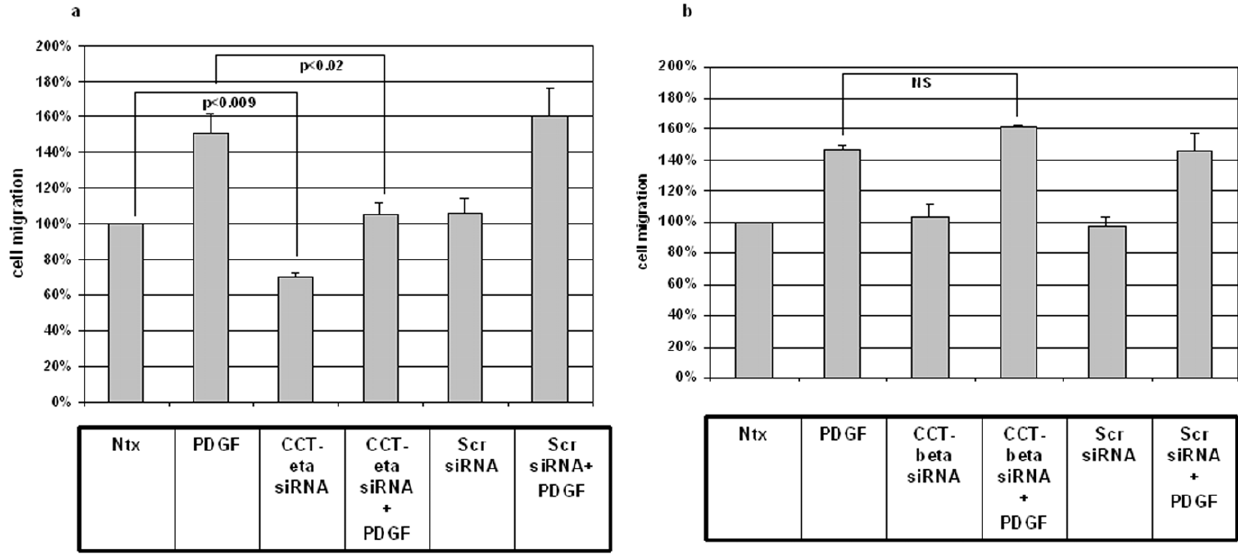
Figure 5. siRNA against CCT-eta decreases PDGF-induced fibroblast migration, whereas siRNA against CCT-beta does not. Cells were incubated in the presence or absence of PDGF (200 nM) + / 2 siRNA against CCT-eta (a) or CCT-beta (b) in an in vitro wound healing assay. In all experiments a subunit -specific scrambled siRNA sequence was used as control. Cell motility is shown as a percentage of baseline migration in the absence of PDGF or siRNA exposure. As with EGF, active siRNA targeting CCT-eta inhibited basal and PDGF-induced motility, whereas CCT-beta siRNA and scrambled controls did not. Values are means 6 SEM of six independent studies, each performed in triplicate. Statistical analyses were performed with Student’s t test.